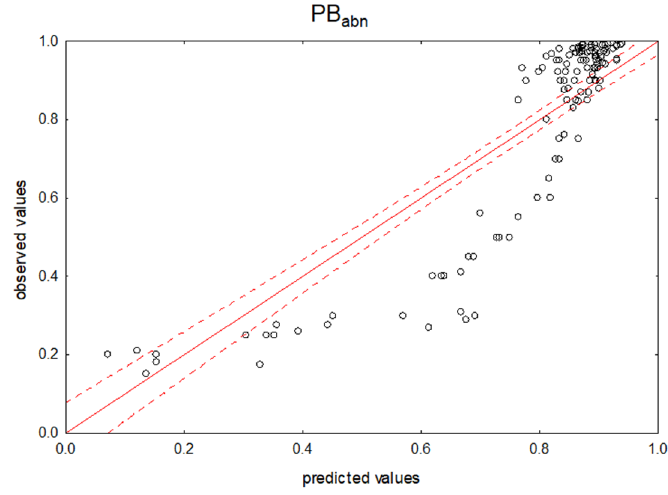
Figure 3. Predicted vs. observed values for MLR model using RP TLC retention data. Dependent variable: PB abn .